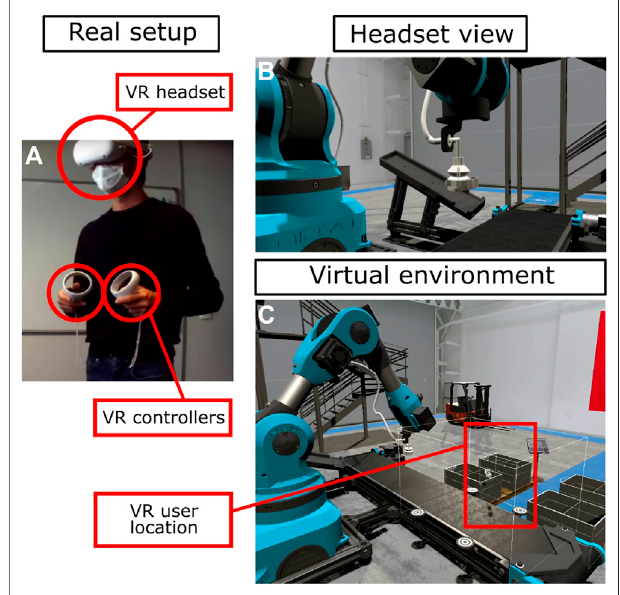
FIGURE 14 | A virtual reality use case involving a Niryo One robot. The user is immersed inside the digital twin thanks to a virtual reality headset (A) . The headset view is displayed in the (B) picture, while the whole virtual environment is shown in the (C) picture.